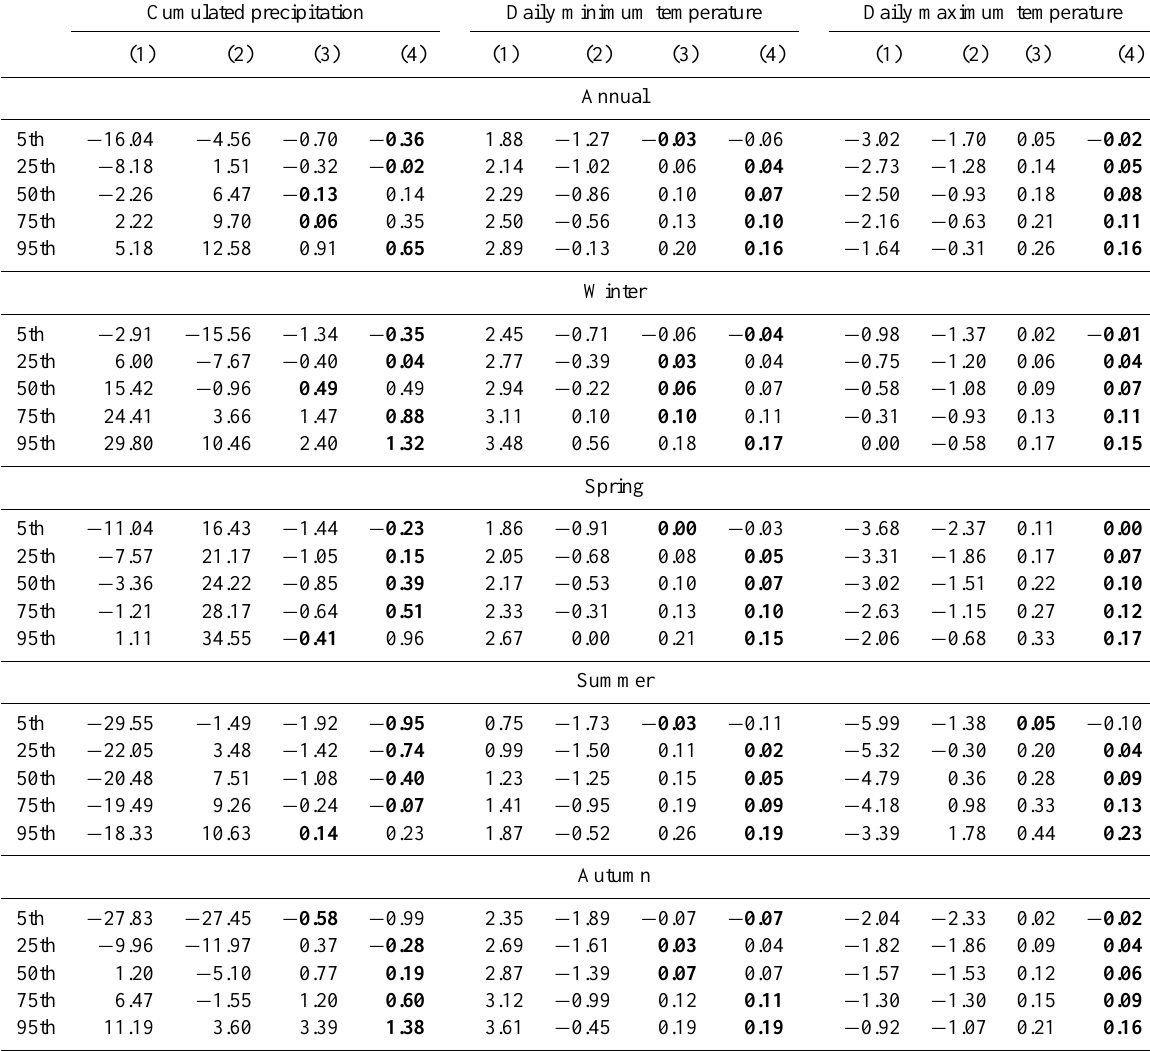
Table 1. Annual and seasonal spatial distribution percentiles of the mean bias. Cumulated precipitation Daily minimum